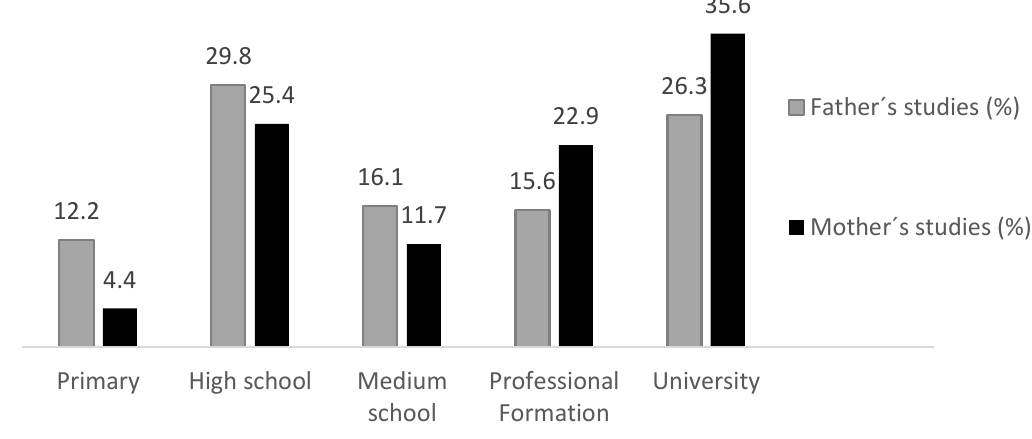
Figure 1. Maximum educational level of father, mother or legal